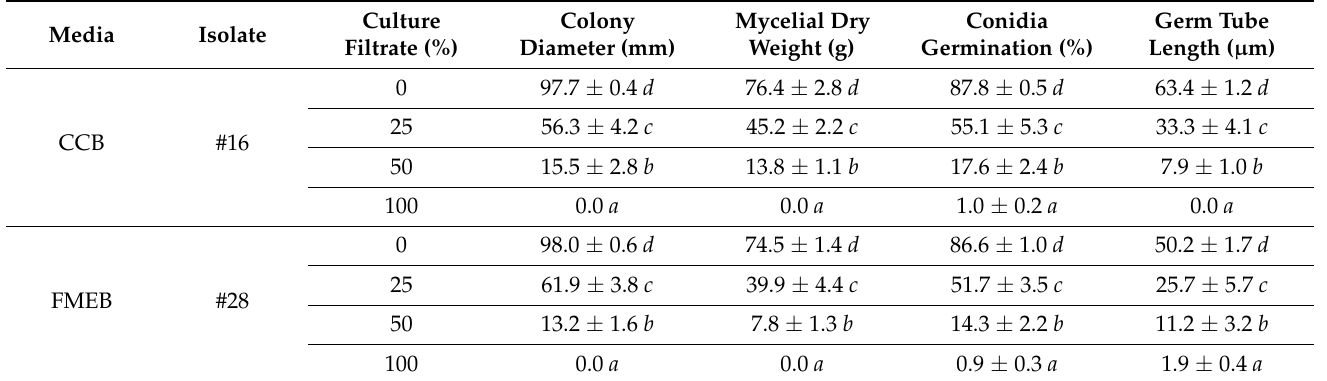
Table 2. Effects of the crude culture filtrate of the two BCA candidates obtained from FMEB and CCB on the mycelial, conidial, and germ tube characteristics of Fusarium solani